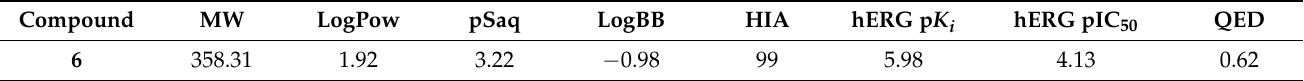
Table 3. Predicted physicochemical and ADMET profiles of compound 6